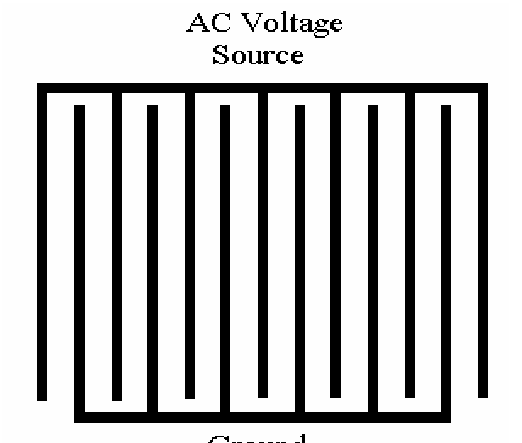
Figure 6. Interdigital sensor structure, where the electrodes follow a finger-like or digit-like pattern.